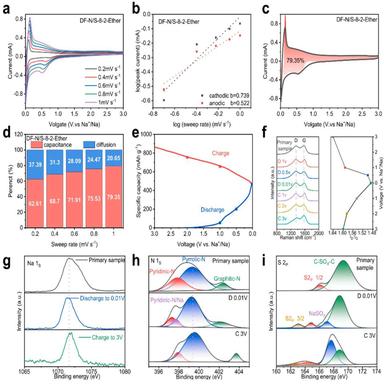
Na+ storage performance of DF-N/S-8–2-800℃ as the half-cell anode in ether-based electrolyte. (a) CV curves in different electrolytes at a scan rate of 0.2–1 mV s − 1 ; (b) Log(i)–log(v) curves; (c) Capacitive contribution at the scanning rate of 1 mV s − 1 ; (d) The contribution ratio of the capacitive capacity at different scan rates; Ex-situ characterizations of DF-N/S-8–2-800℃ anode in ether-based electrolyte; (e) Galvanostatic charge/discharge curve at 0.05 A/g; (f) Ex-situ Raman spectroscopy under var